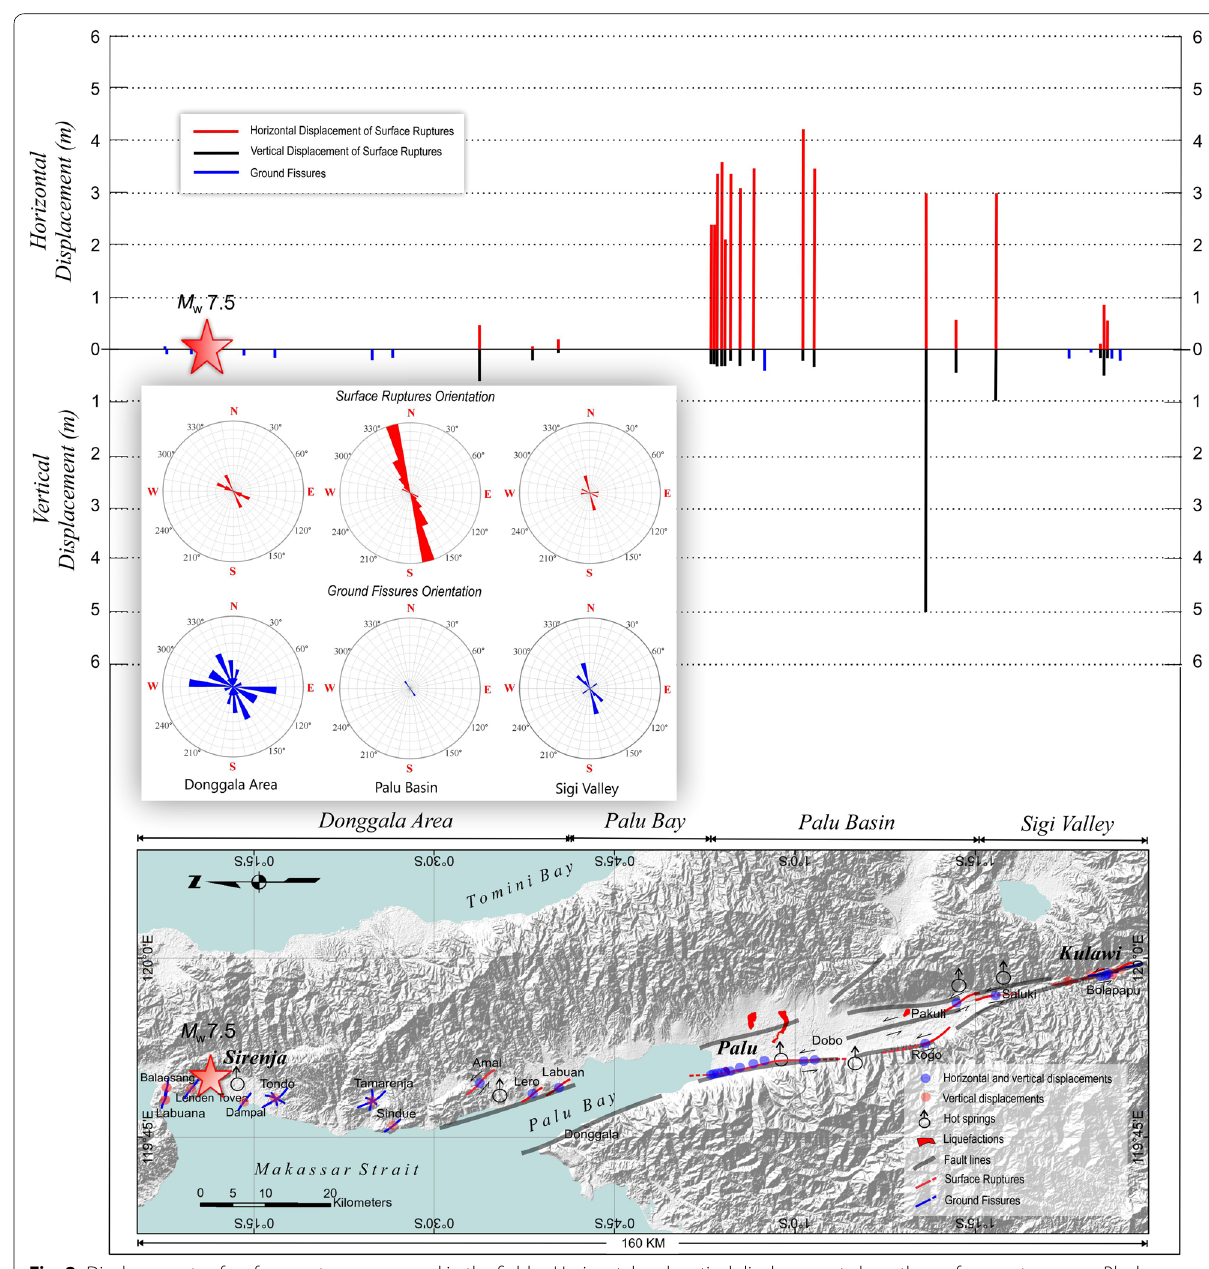
Fig. 2 Displacements of surface ruptures measured in the field. a Horizontal and vertical displacement along the surface rupture zone. Black column: surface rupture, grey column: ground fissures that are not confirmed as surface rupture. b Distribution of surface rupture formed by the 2018 earthquake (red line), ground fissure (blue line), and tectonic lineament of presumed fault (grey line). The length of ruptures and ground fissures showed on the map are exaggerated. The base map is a 30 m DEM-SRTM (USGS). Rose diagrams of fracture orientations are also shown. Original data to make distribution of surface rupture in Fig. 2 are compiled in Additional file